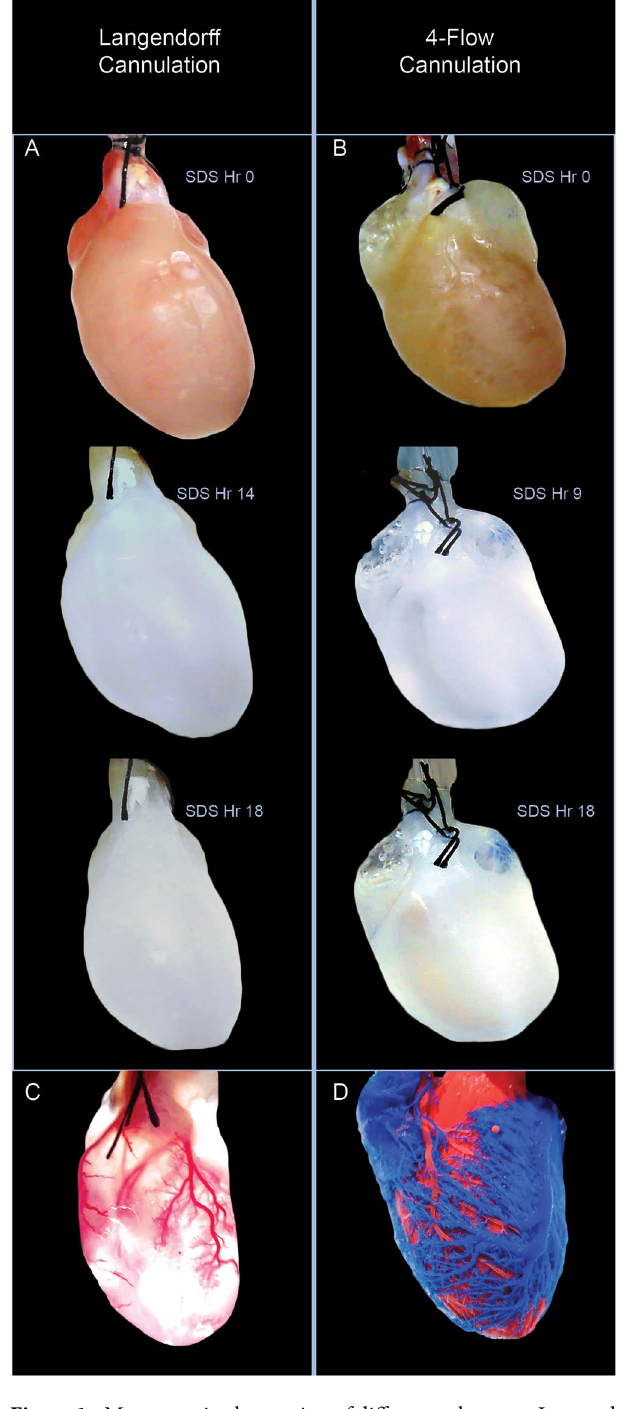
Figure 1. Macroscopic observation of differences between Langendorff and 4-Flow cannulated hearts decellularized and resin casted. ( A , B ) Time lapse comparison between Langendorff and 4-Flow cannulation perfused with 3 L of 1% sodium dodecyl sulfate solution under constant pressure. The 4-Flow cannulated hearts has the most clarity in all chambers of the heart. ( C , D ) Perfusion of the colored resin casting polymer illustrates the limited accessibility of the Langendorff cannulation as compared to the vascular interaction between coronary arteries and cardiac veins of the 4-Flow heart. The red colored polymeric solution was perfused through the AA for both the Langendorff and 4-Flow hearts while the blue colored polymeric solution was perfused through the SV of the 4-Flow heart. ( C ) The decellularized tissue was intentionally preserved for the Langendorff resin cast; however, ( D ) the tissue was removed in the 4-Flow heart. Images are representative of replicates (n =